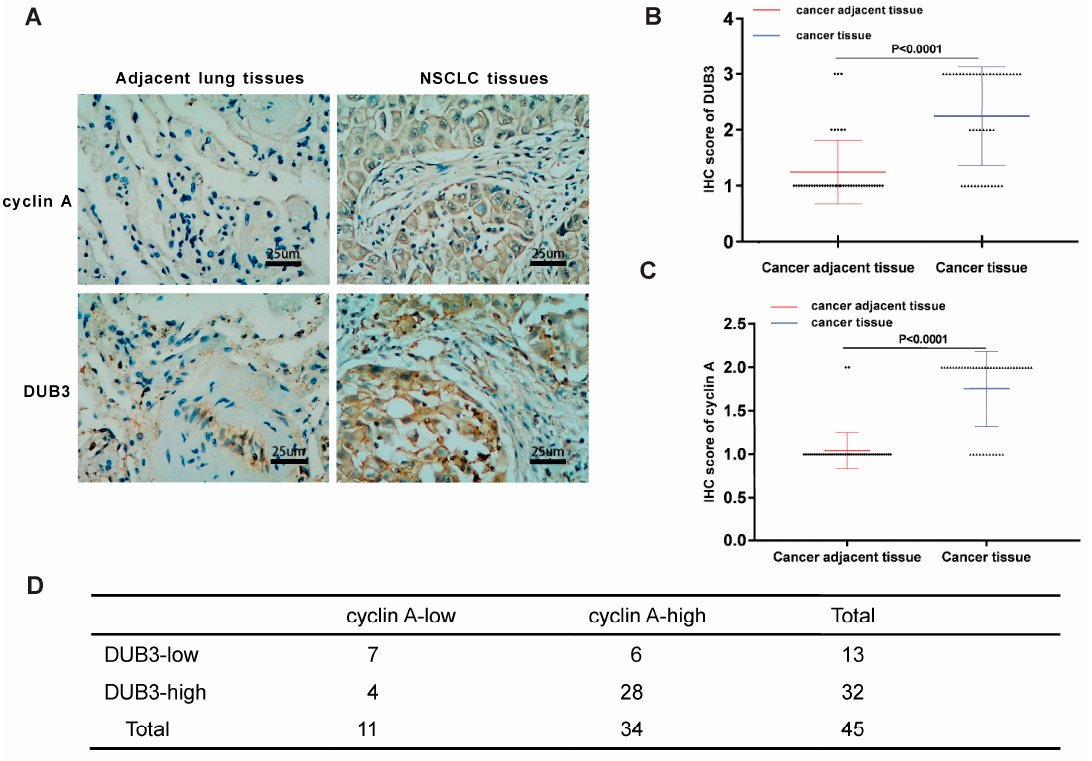
Figure 7. DUB3 and cyclin A are overexpressed and positively correlated in NSCLC samples. ( A ) Representative images from immunohistochemical staining of DUB3 and cyclin A in adjacent lung tissues and NSCLC tissues were shown. Scale bars, 25 µ m. ( B , C ) DUB3 ( B ) cyclin A ( C ) protein expression status in adjacent lung tissues and NSCLC tissues. ( D ) A summary of immunohistochemical staining for the correlation between DUB3 and cyclin A in NSCLC. The statistical analysis was determined by a X 2 test.